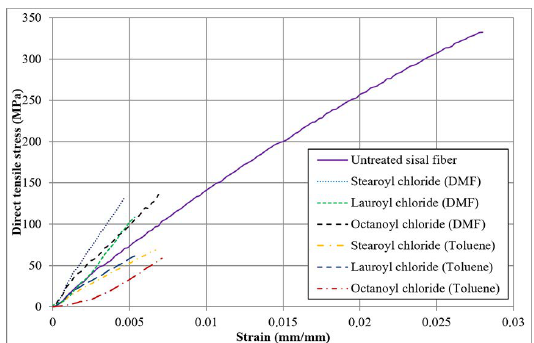
Figure 5. Typical stress-strain diagram obtained in tensile tests of the